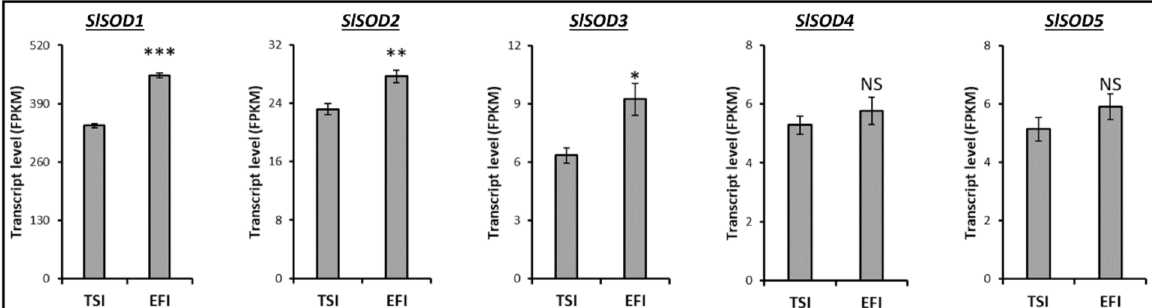
Figure 5. Effect of top sprinkle (TSI) and ebb-and-flow (EFI) irrigation on transcript profiling of SOD genes in tomato root. Vertical bars indicate means ± SE (3 biological and 3 techincal replicates). The *, ** and *** represent significance at p ≤ 0.05, p ≤ 0.01 and p ≤ 0.001, respectively, according to Student’s t -test. NS–not